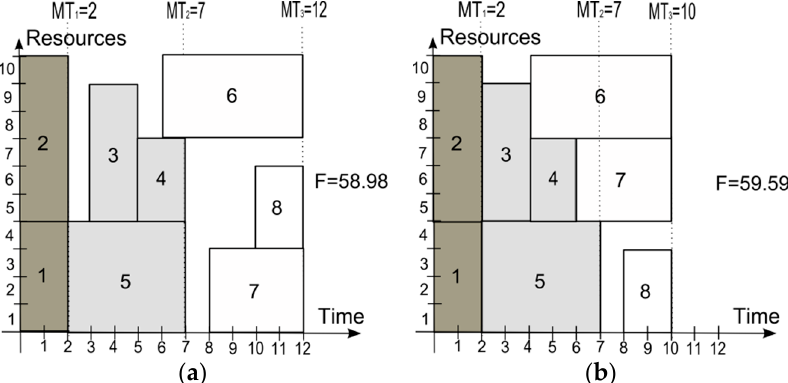
Figure 5. ( a ) Schedule determined as a result of optimization of the completion time of 2nd stage with MT 1 = 2, MT 2 = 7, MT 3 = 12, ( b ) schedule as a result of optimization of completion times of all stages: MT 1 = 2, MT 2 = 7, MT 3 =